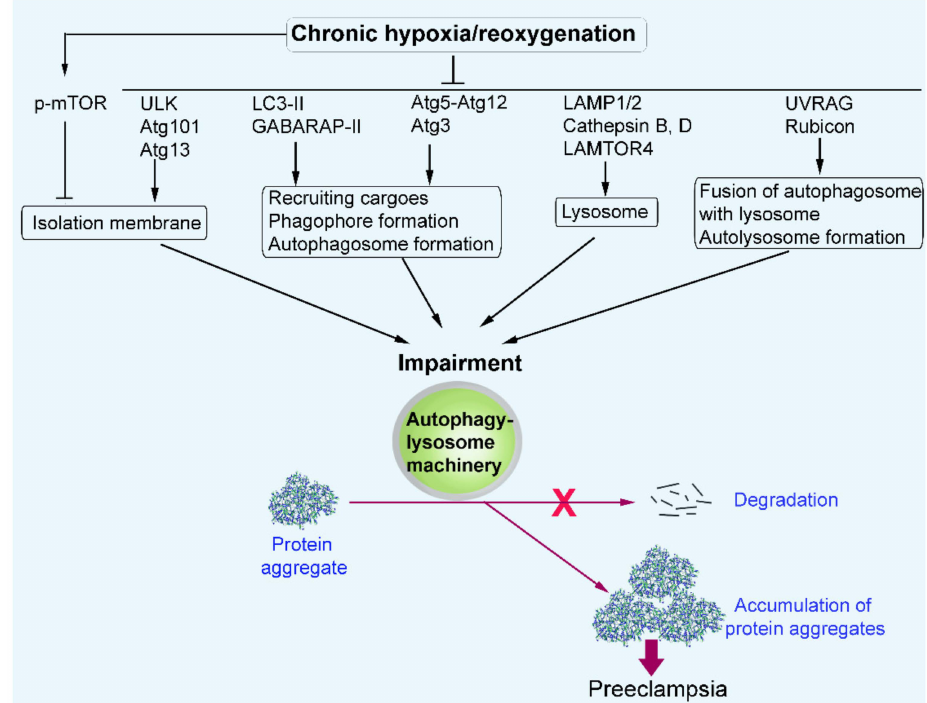
Figure 7. Working model for the effect of chronic hypoxia/reoxygenation on the autophagy– lysosome machinery. Chronic hypoxia/reoxygenation negatively affects the expression of